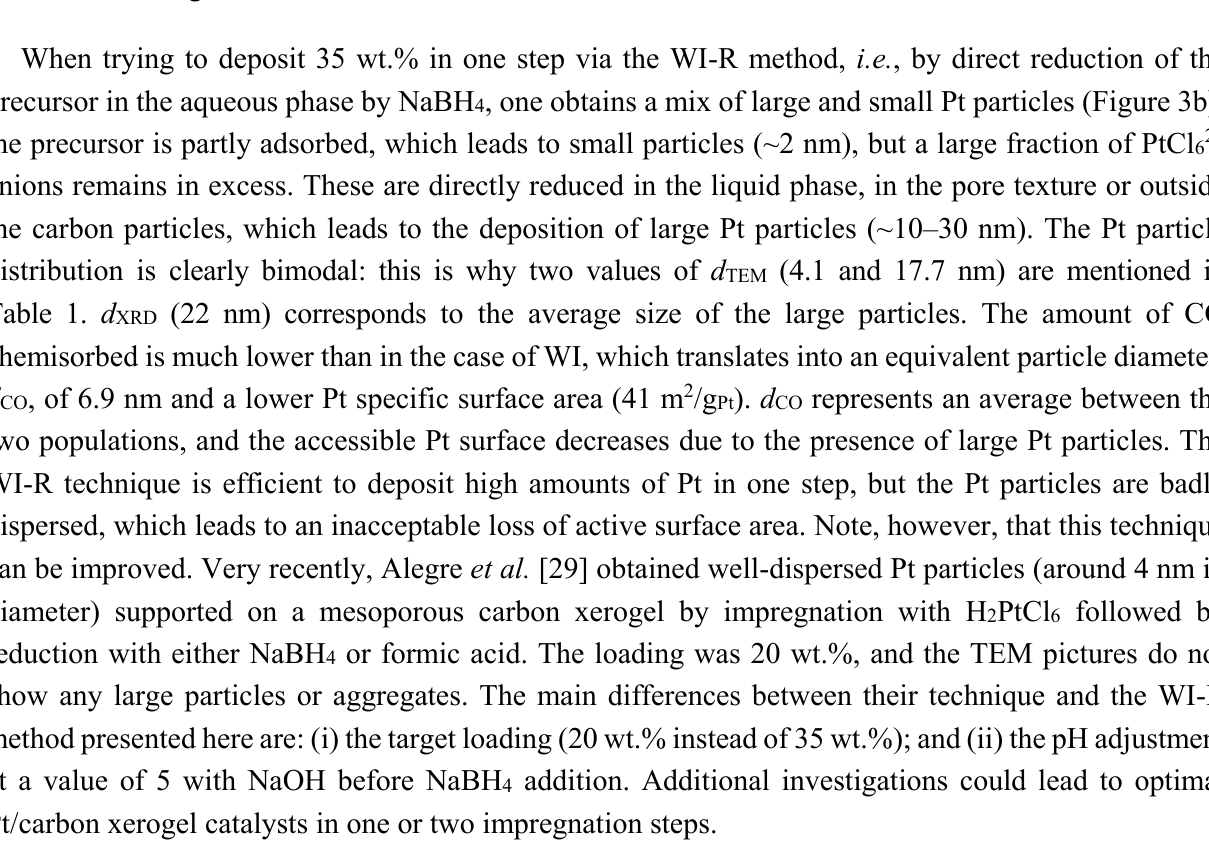
Figure 3. TEM and STEM images of Pt/C catalysts: ( a ) WI (1.9 wt.%); ( b ) WI-R (31.0 wt.%), ( b' ) magnified inset of WI-R; ( c ) SEA (7.5 wt.%), ( d ) M-SEA-723 (double SEA, 15.0 wt.%); ( e ) M-SEA-r (double SEA with recycling, 14.7 wt.%); and ( f ) CEDI-473 (10 wt.%), STEM